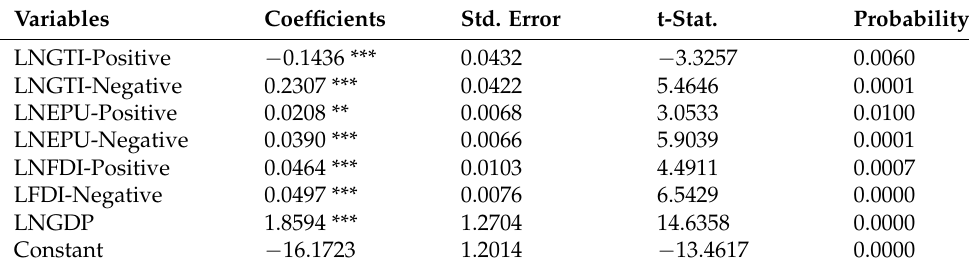
Table 11. NARDL long-run estimates.